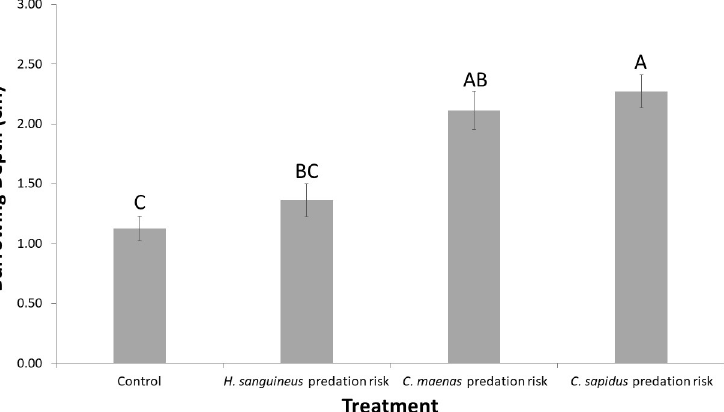
Fig 1. M . mercenaria burrowing experiment: Mean burrowing depth (cm) over seven-day trials. The four treatments included (1) a control where clams were not exposed to predators, or (2–4) predation risk from H . sanguineus (recently-introduced non-native species), C . maenas (long-established non-native species), or juvenile C . sapidus (native species). Error bars indicate standard error and different letters above bars indicate significant differences among treatments at α = 0.05, as determined using a Tukey’s HSD